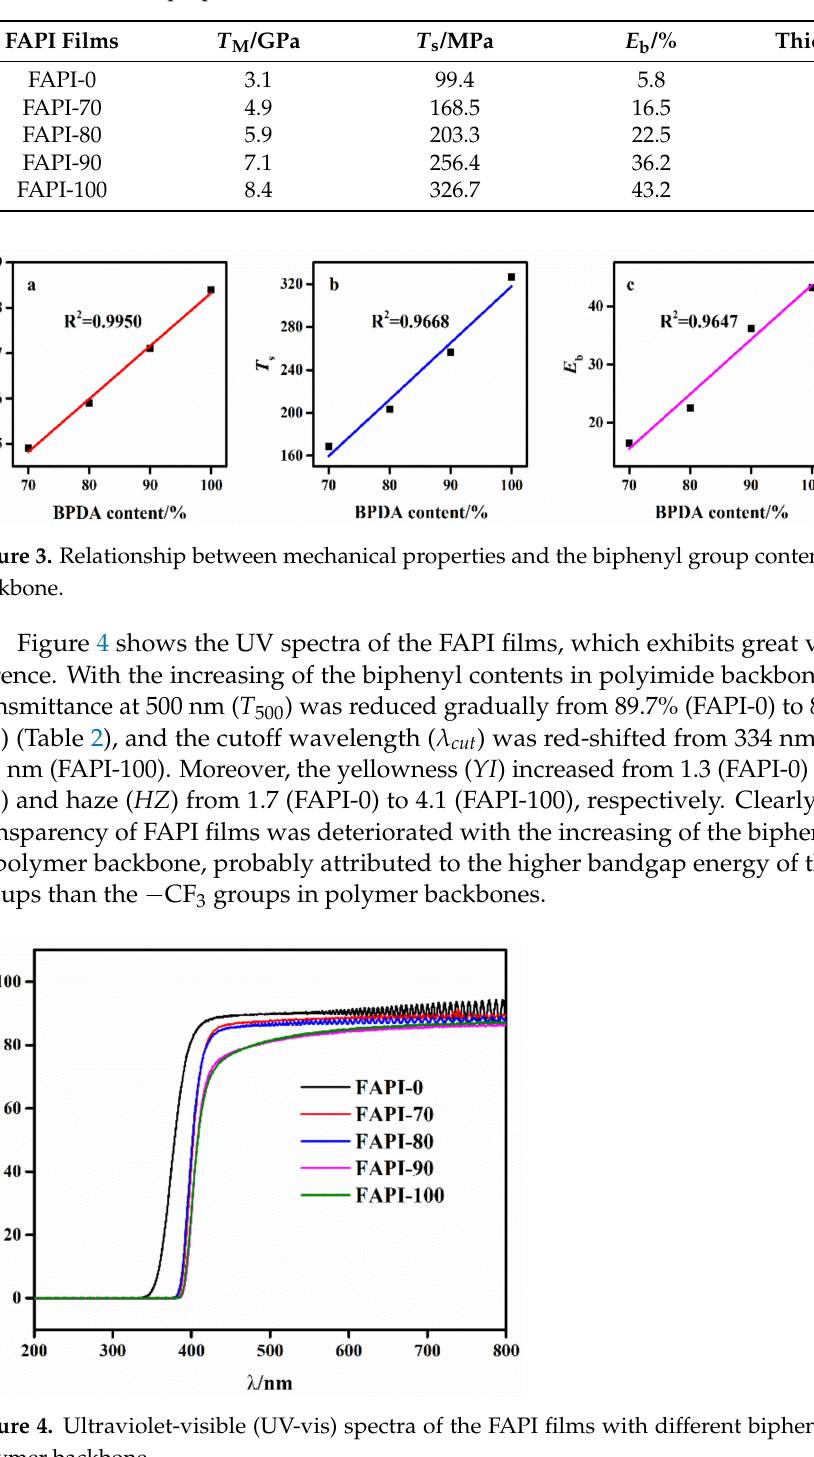
Table 1. Mechanical properties of the FAPI films.